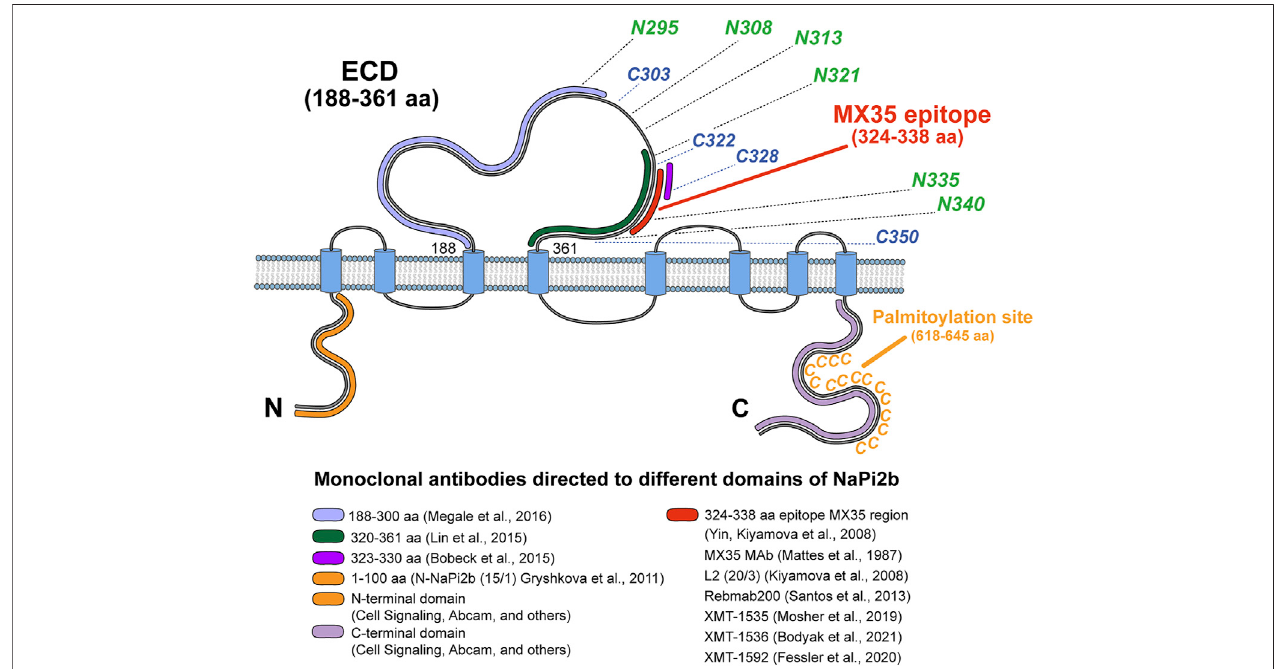
FIGURE 4 | Topological model of NaPi2b with color-coded antigenic regions recognized by available monoclonal analytical and therapeutic antibodies targeting different extramembrane domains. The epitope ’ s region in ECD of NaPi2b for mAbs, generated by: Megale et al. (2016), 188 – 300 aa, marked in light purple; Lin et al. (2015), 320 – 361 aa, marked in green; Bobeck et al. (2015), 323 – 330 aa, marked in purple; Yin, Kiyamova et al. (2008), Mattes et al. (1987), Kiyamova et al. (2008), Santosetal.(2013),Mosheretal.(2019),Bodyaketal.(2021),Fessleretal.(2020),324 – 338aa,markedinred;EpitoperegioninN-terminiandC-terminiofNaPi2b for mAbs, generated by: Gryshkova et al. (2011), Cell Signaling, Abcam, and others against N-terminal domain of NaPi2b, 1 – 100 aa, marked in orange; Cell Signaling, Abcam, and others against S -terminal domain of NaPi2b, the region is unknown, marked in lavender. Positions of cysteine and asparagine amino acid residues potentially contributing to the oxidative folding and formation of disul fi de bonds and N-linked glycosylation of the largest ECD, and palmytoilation site in C-terminal domain are also